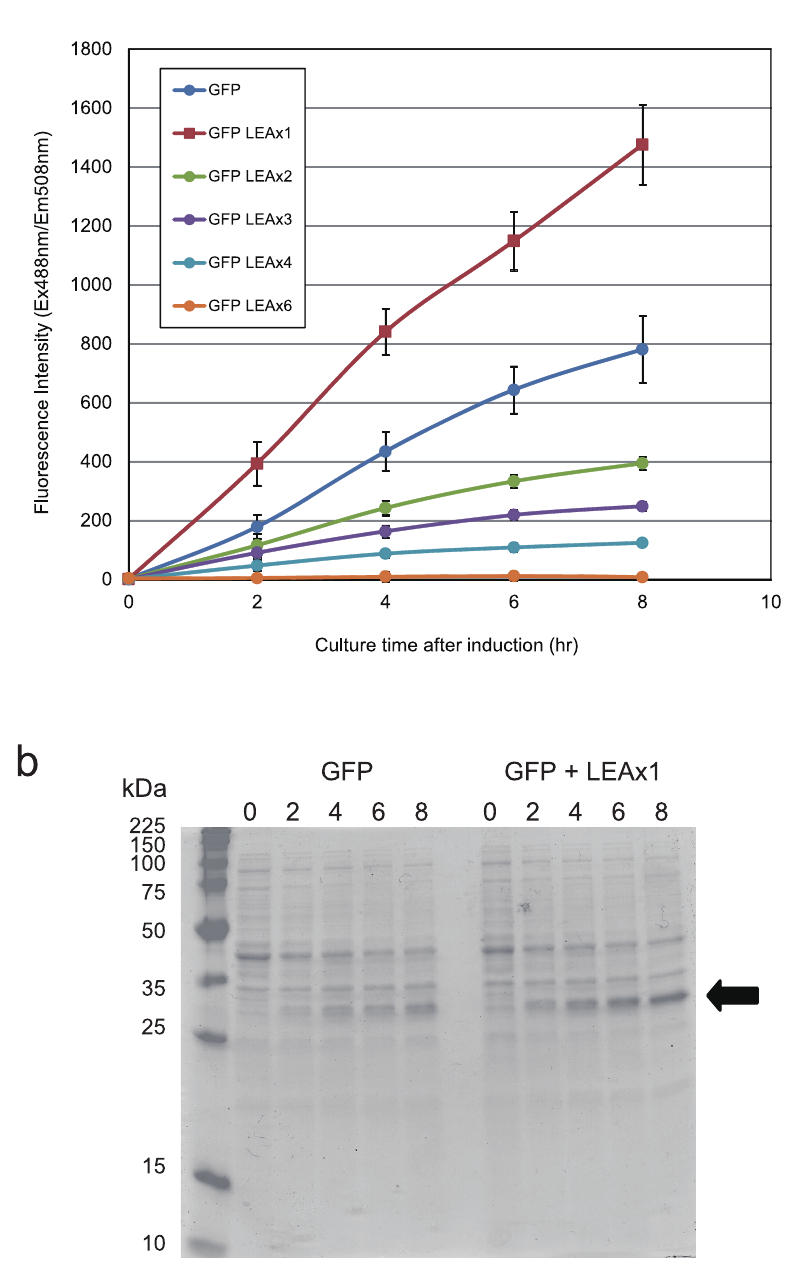
Figure 1. Effect on GFP expression of co-expression with LEA-like peptide in E.coli. (a) Time dependence of GFP expression after IPTG induction (b) The GFP expression with or without 11amino acids LEA-like peptide were analyzed by SDS-PAGE